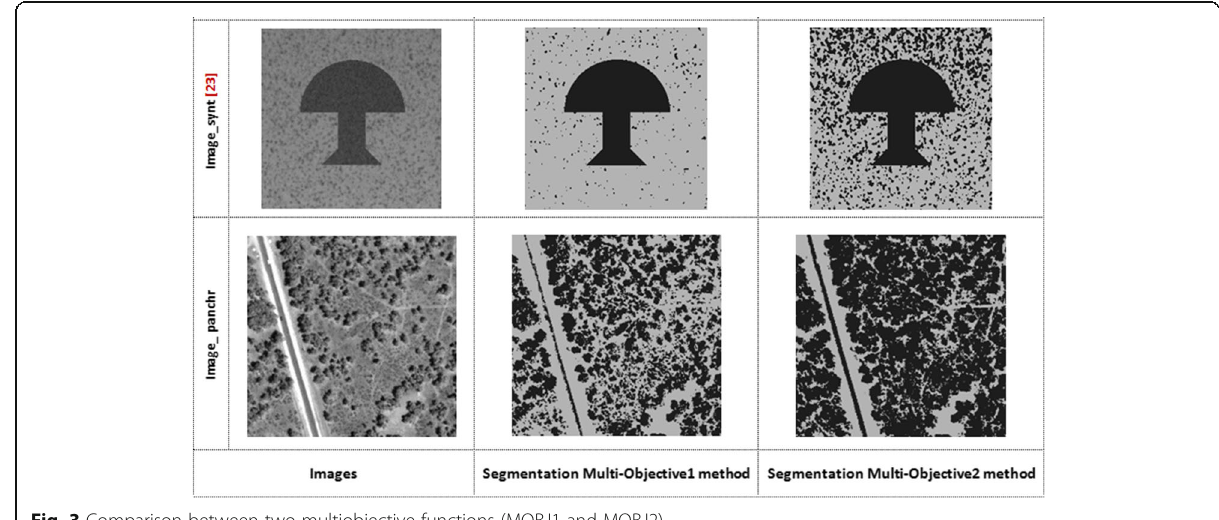
Fig. 3 Comparison between two multiobjective functions (MOBJ1 and MOBJ2)